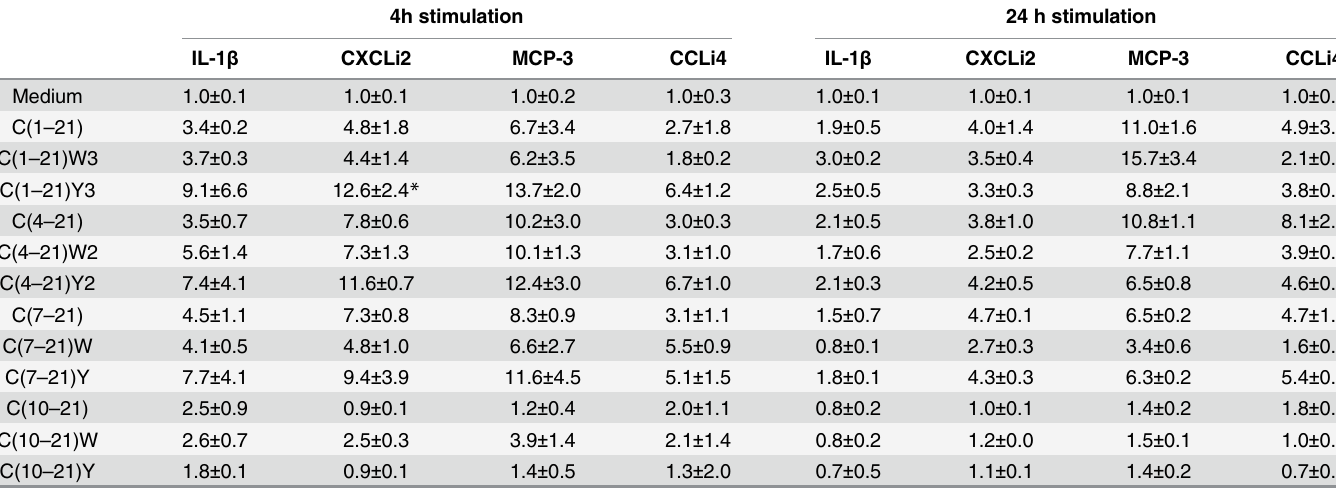
Table 3. Effect of aromatic amino acid substitution on HD11 cytokine expression levels.